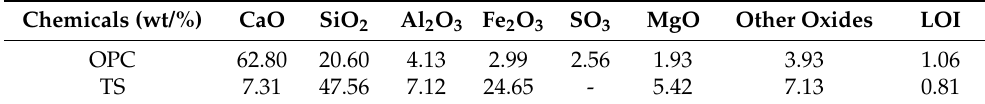
Table 1. The chemical compositions of OPC and TS.